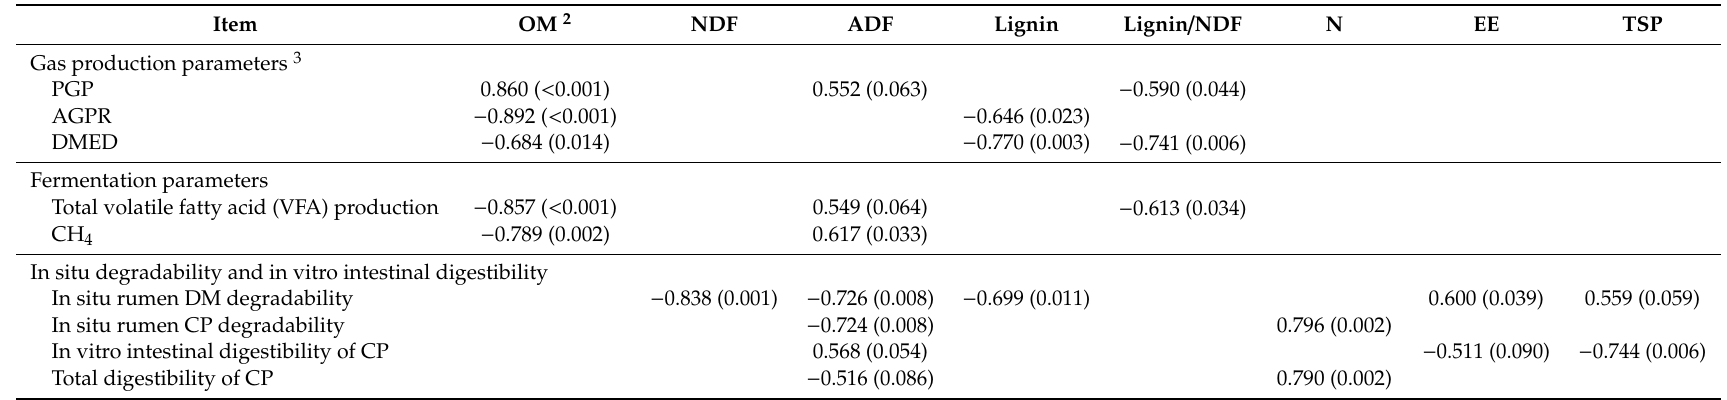
Table 5. Correlation matrix (Pearson coe ffi cient and p -values in brackets; n = 12) of chemical composition of tomato pomace samples with gas production